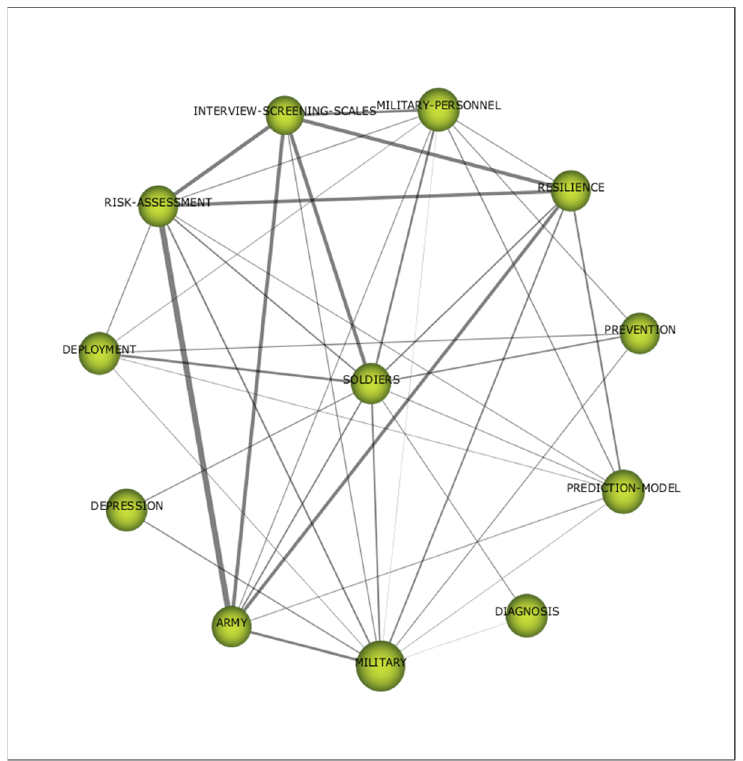
Figure 11. Category: Soldier analytics; From 2016; Theme: Soldiers.